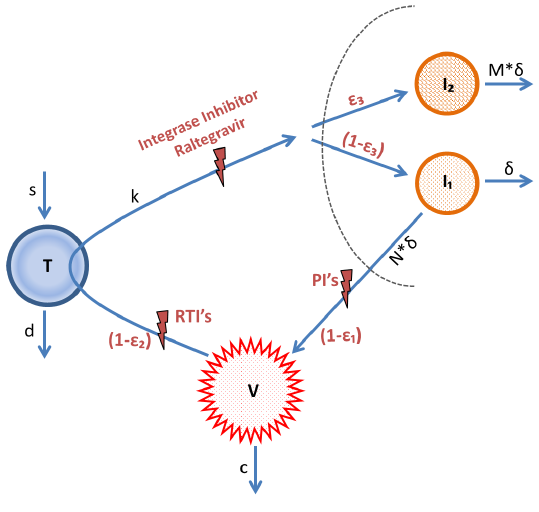
Fig. 3. Model of viral infection under combination treatment.